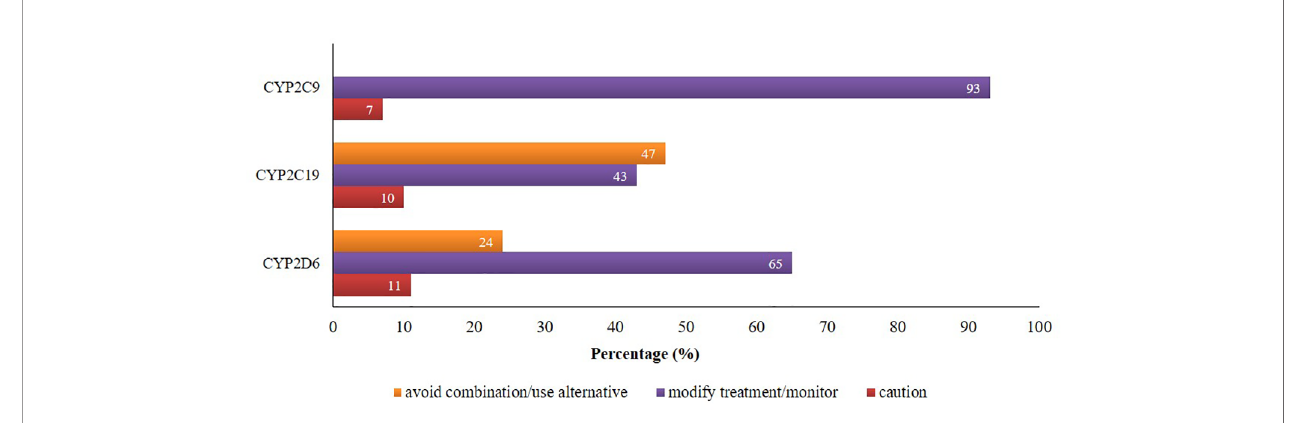
FIGURE 2 | Proportion of potential DDIs based on the suggested managements provided by Epocrates ®